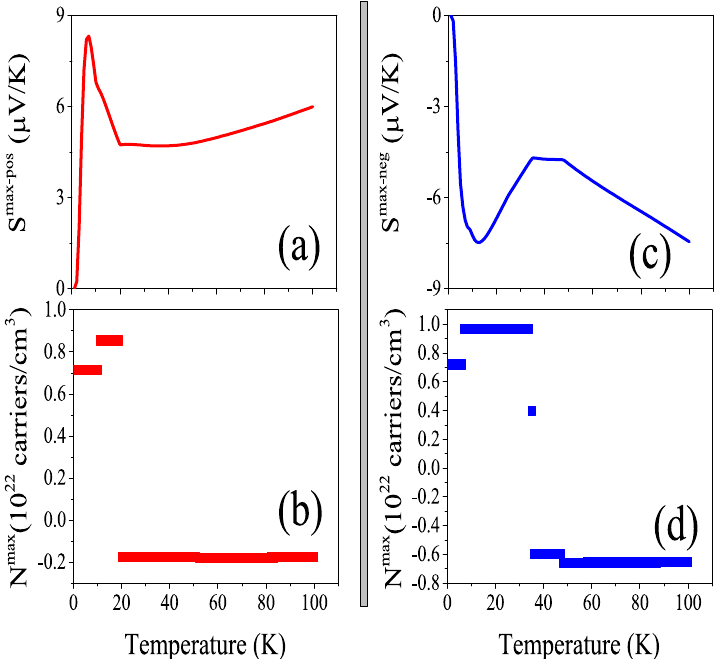
Figure 9. Maximum positive or hole-like of spin up Seebeck coefficient ( S max − pos ) and ( b ) maximum negative or electron-like of spin up Seebeck coefficient ( S max − neg ) of hole/electron doped CeIn 3 versus temperature calculated by GGA+U with U eff = 5.5 eV for the P = 0 pressure. Doping levels related to the S max − pos and S max − neg are displayed in the ( c ) and ( d ) panels,